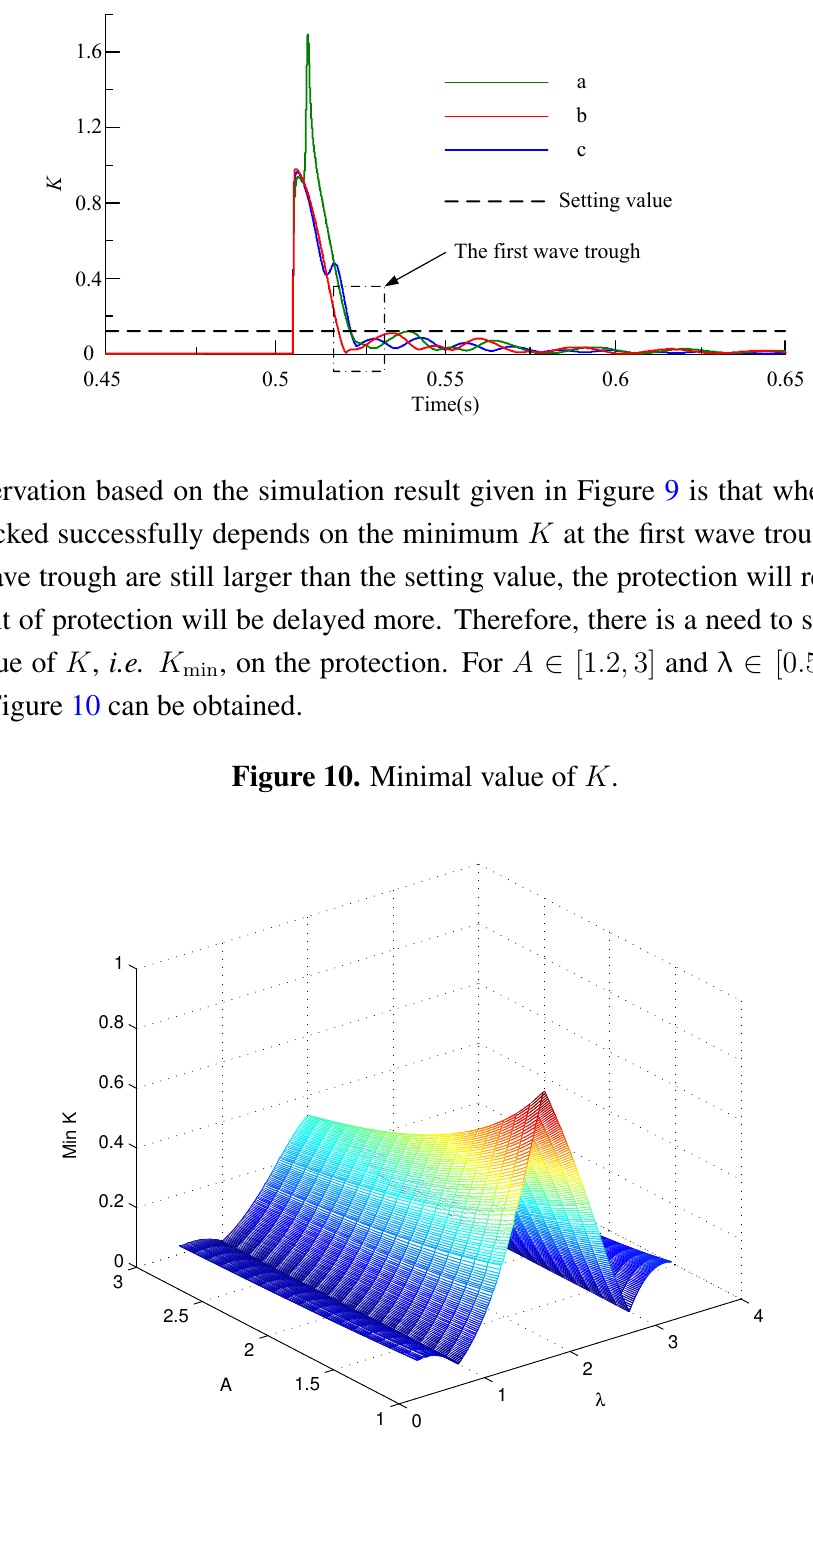
Figure 9. Simulation result on second harmonic restraint protection.